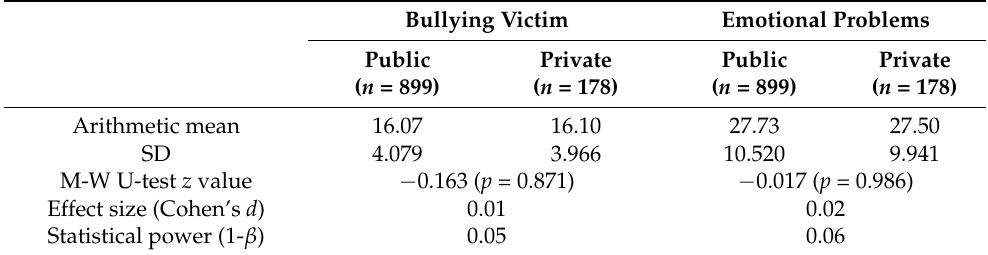
Table 8. Comparison of means according to the ownership of the